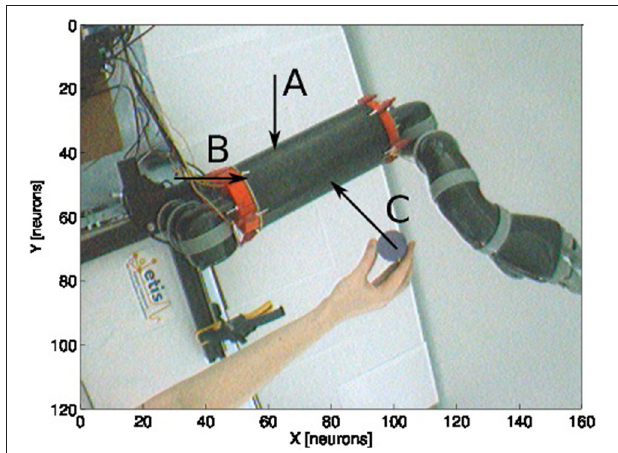
FIGURE 12 | Experience 3 – Arm-centered receptive fields. Experience done for three looming targets at different locations (A–C) in the direction of the